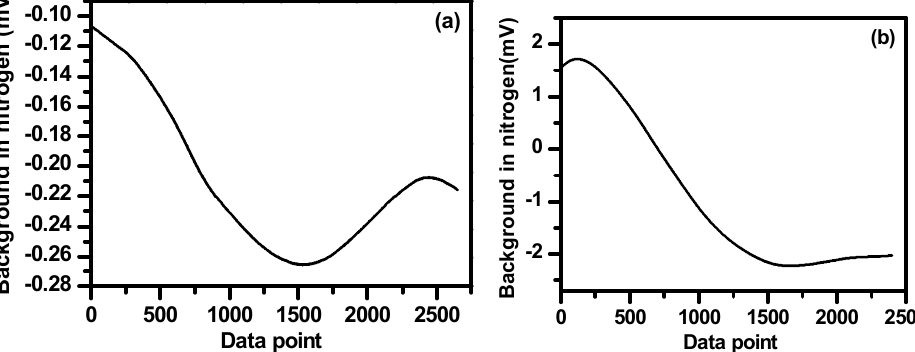
Figure 10. Baselines of nitrogen measured in the methane ( a ) and ethane ( b ) channels.